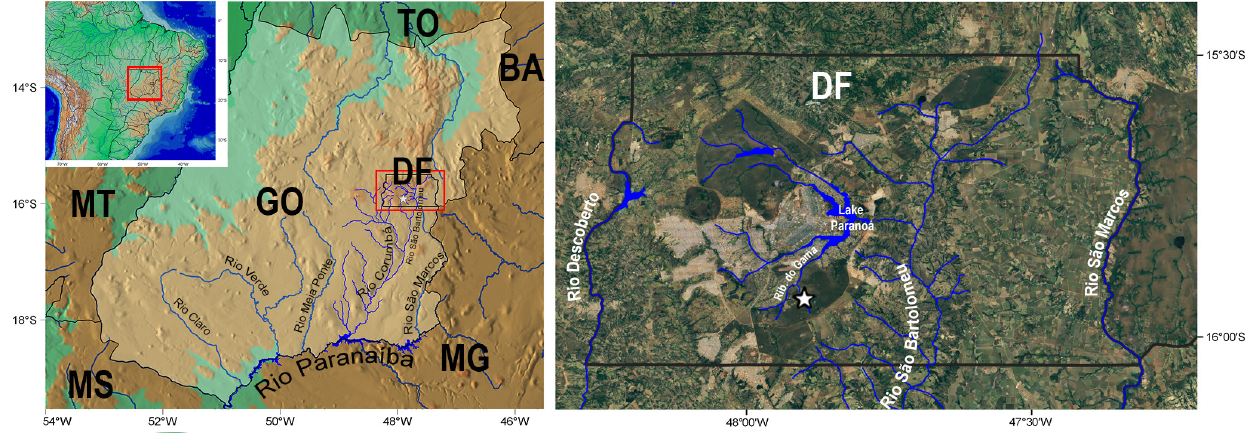
FIGURE 6 | Maps of the tributaries of rio Paranaíba in Goiás State, Brazil in general view (left), with the rio São Bartolomeu basin detailed in the Distrito Federal (right). The type locality of Characidium onca is indicated by a star in the córrego Taquara. Abbreviations: BA, Bahia; DF, Distrito Federal; GO, Goiás; MG, Minas Gerais; MS, Mato Grosso do Sul; MT, Mato Grosso; and TO,